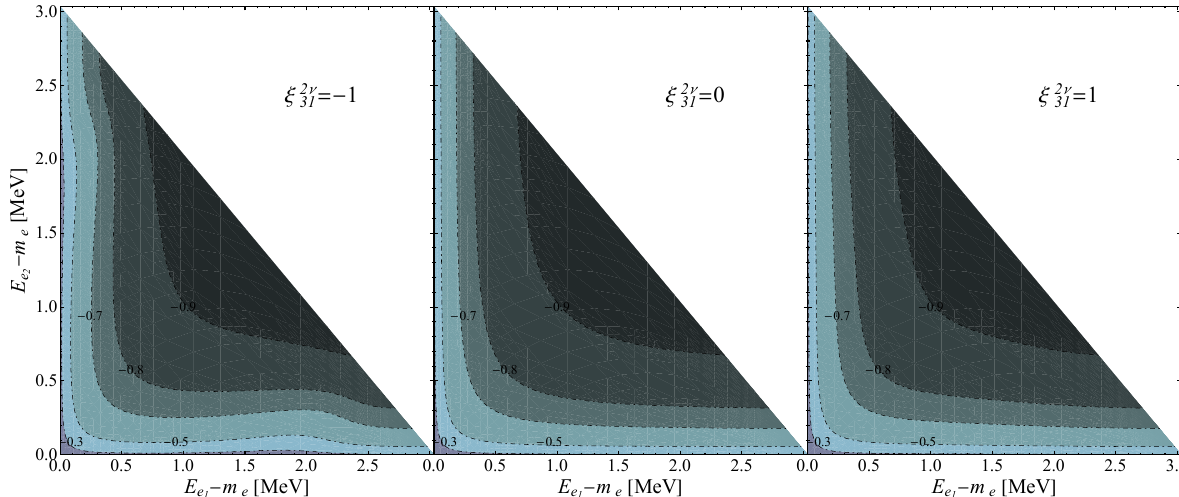
Figure 4. The angular correlation κ 2 ν as function of electron energies emitted in the 2 νββ -decay of 100 Mo. The distributions = − 1, 0 and 1. The distributions were calculated by using the screened exact finite-size Coulomb are obtained using ξ 2 ν 31 wave functions for s 1/2 electron state.